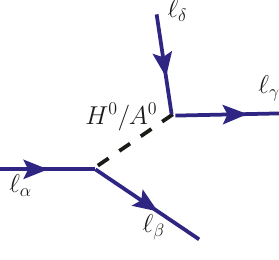
Figure 9 . Feynman diagram contributing to tree-level cLFV trilepton decay mediated by and odd neutral scalars in the Zee model. At least two of the (cid:12)nal state leptons must be of electron (cid:13)avor to be relevant for